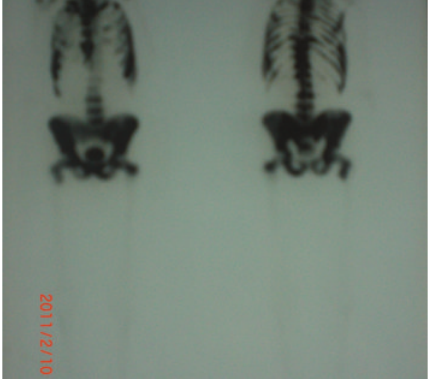
Figure 3: MRI showed that 5 × 8 mm mass the has irregular bor- derline